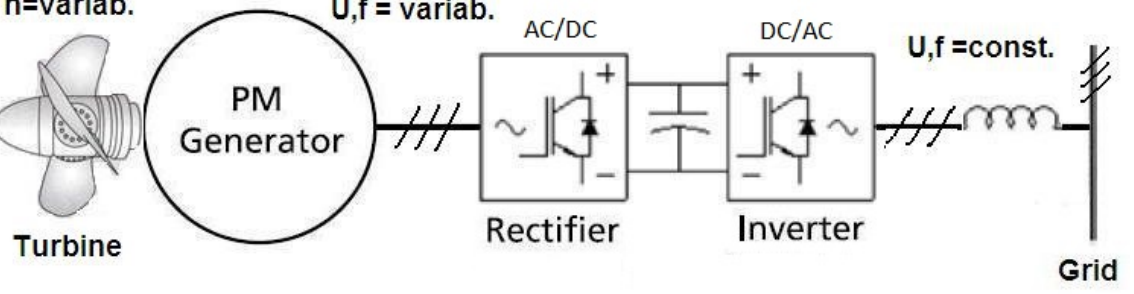
Figure 3. Energy conversion system with a permanent magnet synchronous generator connected to the power system through a power electronic converter (PEC).